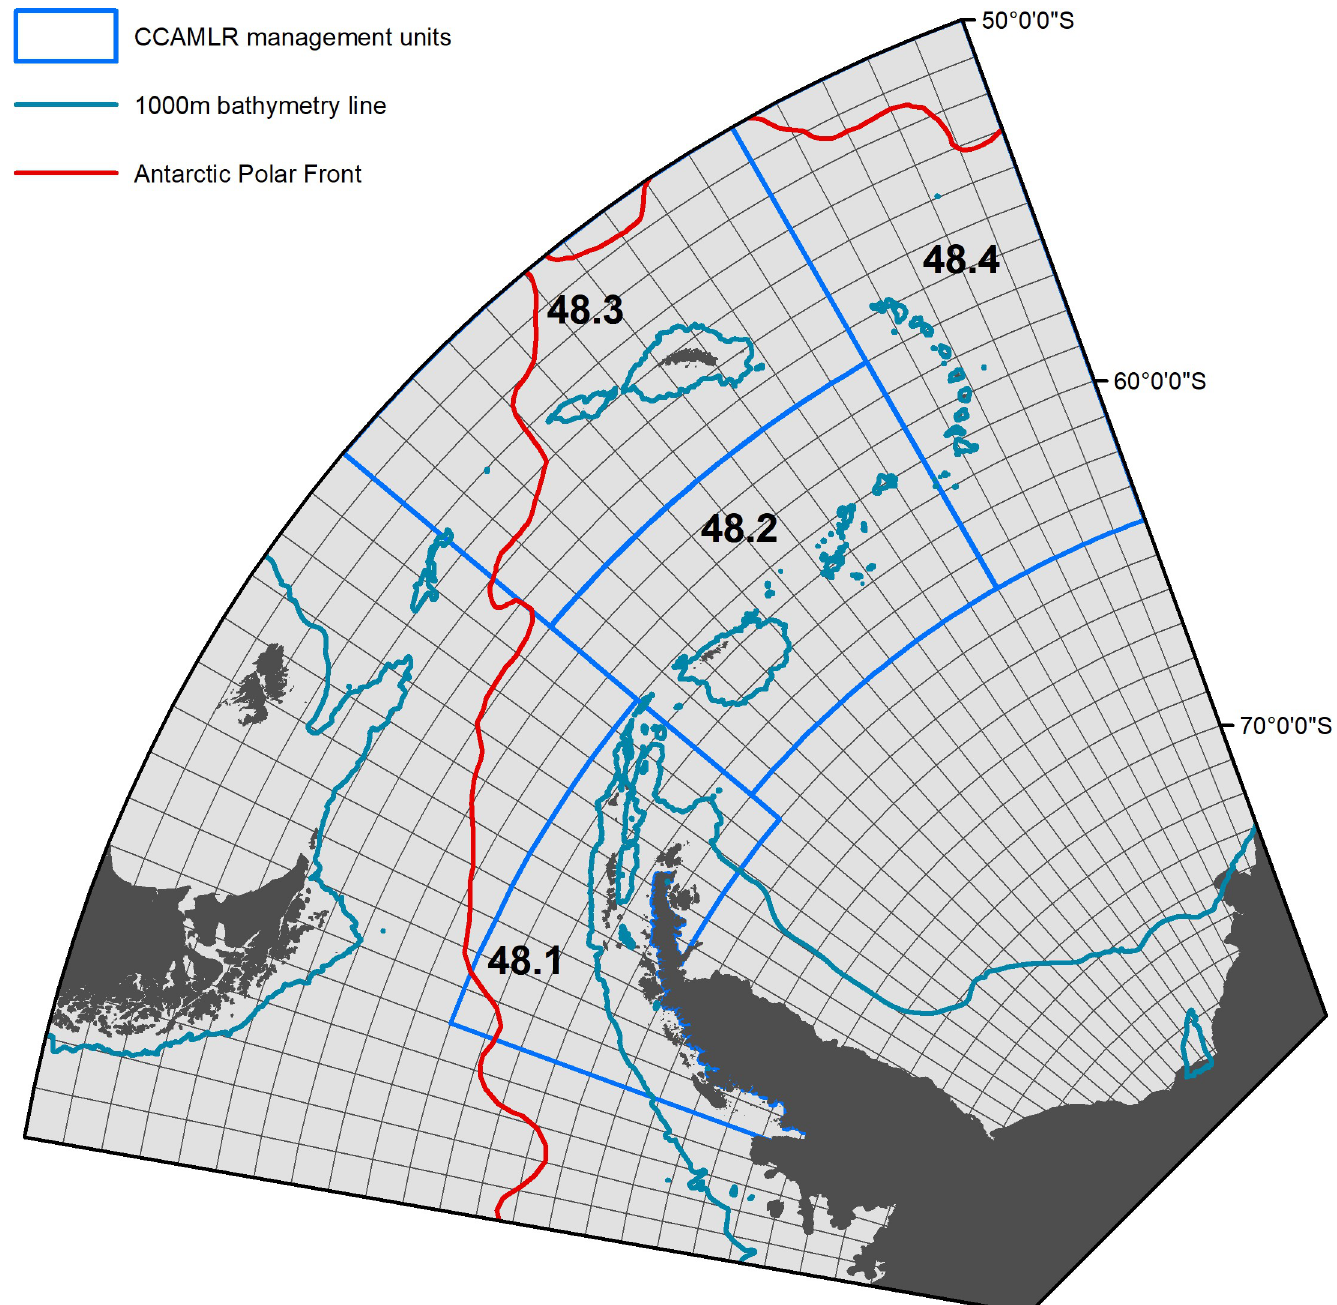
Fig 1. The study area. Also depicted are CCAMLR management subareas (each of which has its own catch limit), 1000m bathymetry line, Antarctic Polar Front and the 1˚latitude by 2˚ longitude grid cells used for this